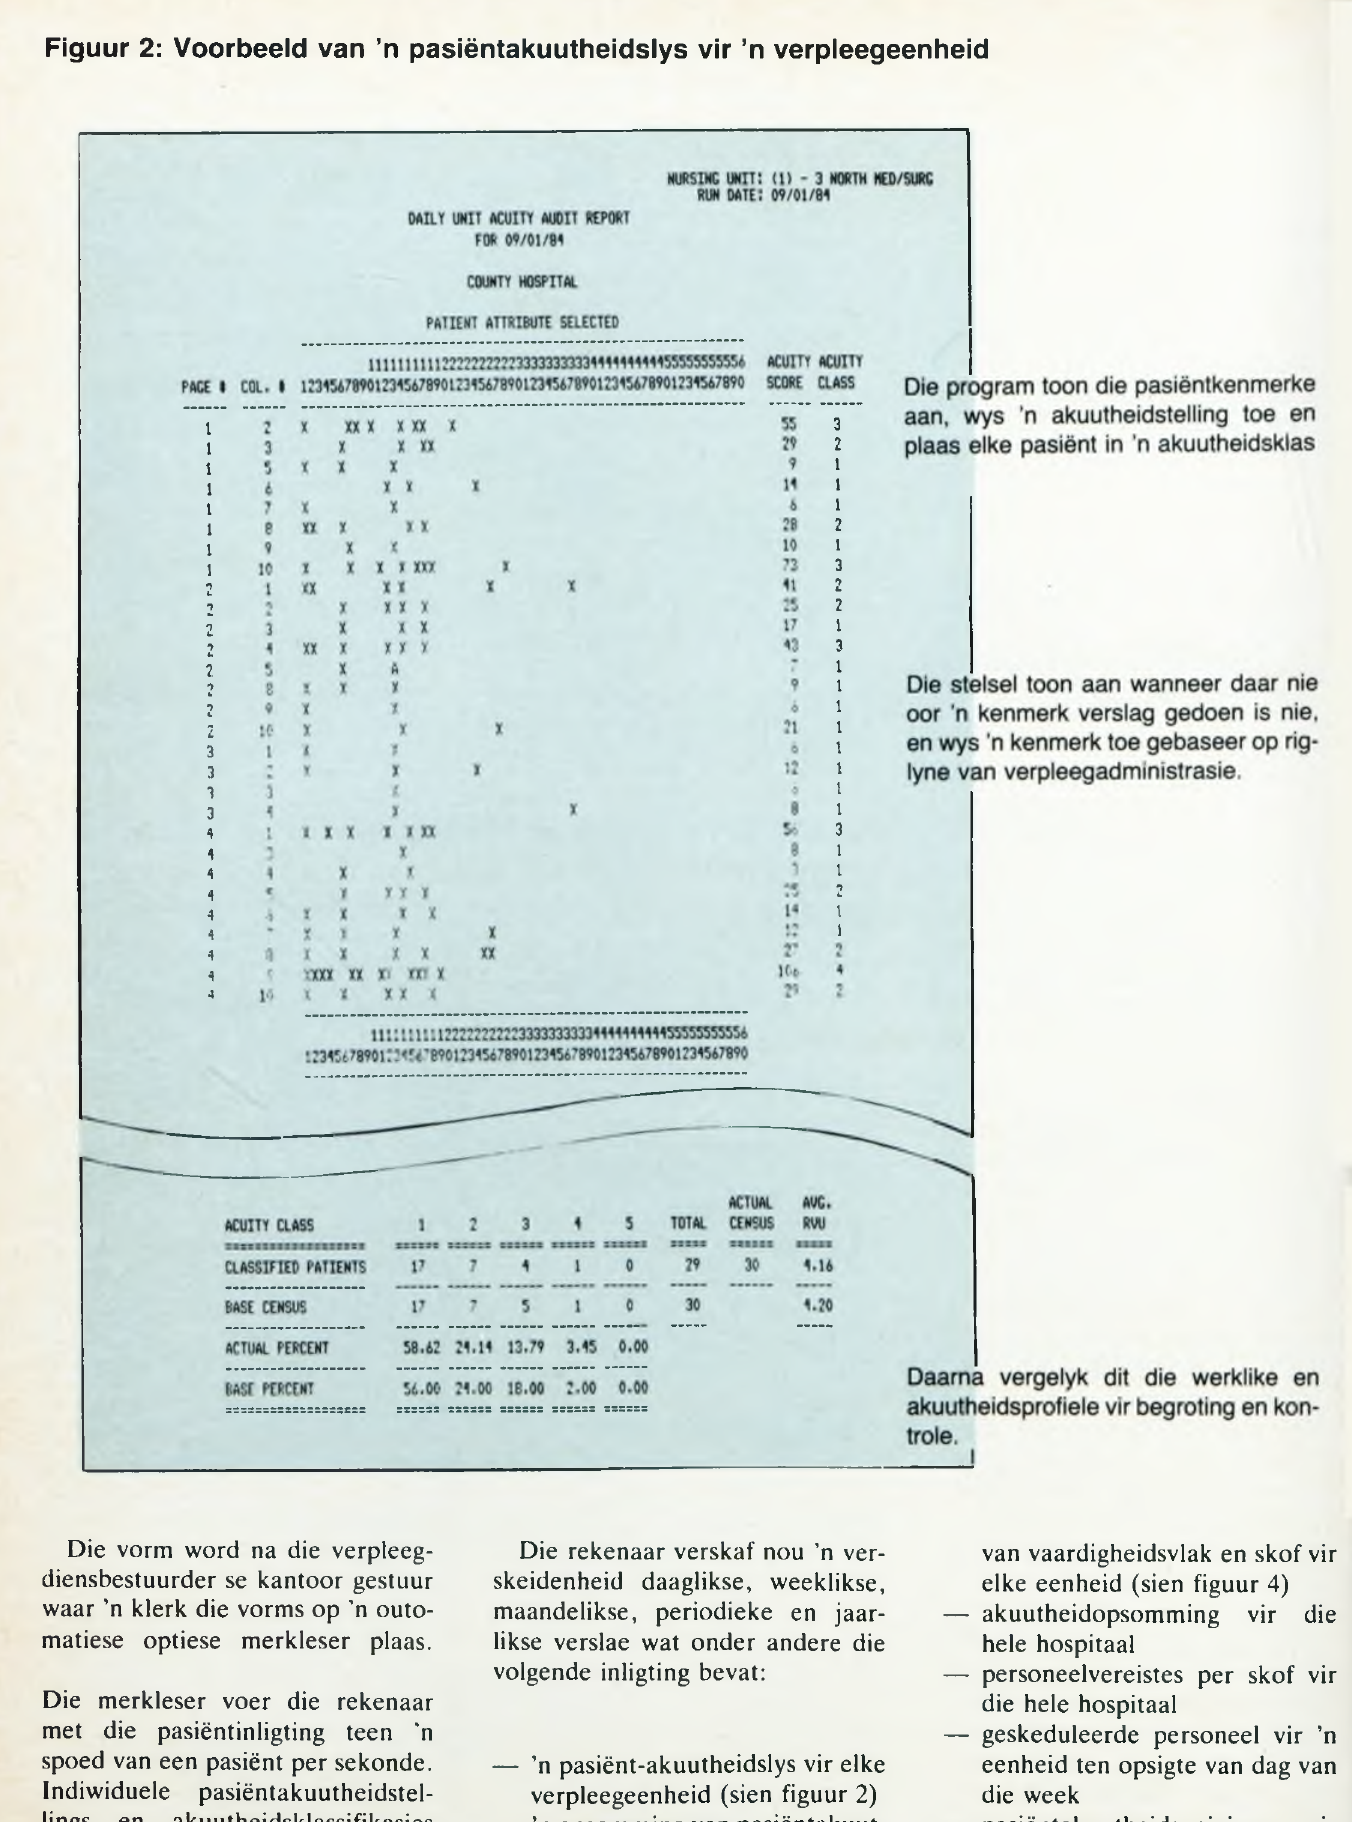
Die vorm word na die verpleeg- diensbestuurder se kantoor gestuur waar ’n klerk die vorms op ’n outo- matiese optiese merkleser